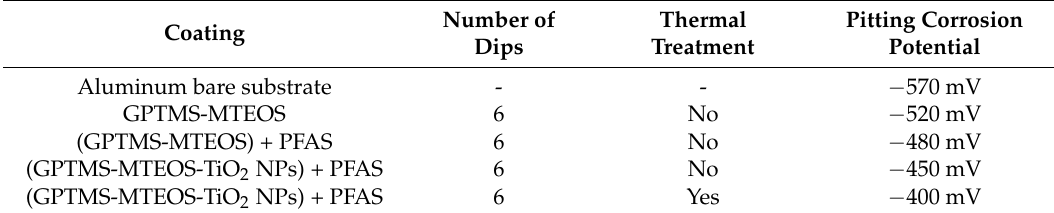
Table 4. Summary of the pitting corrosion potential values obtained as a function of two experimental variables: number of dips and thermal treatment (curing step).